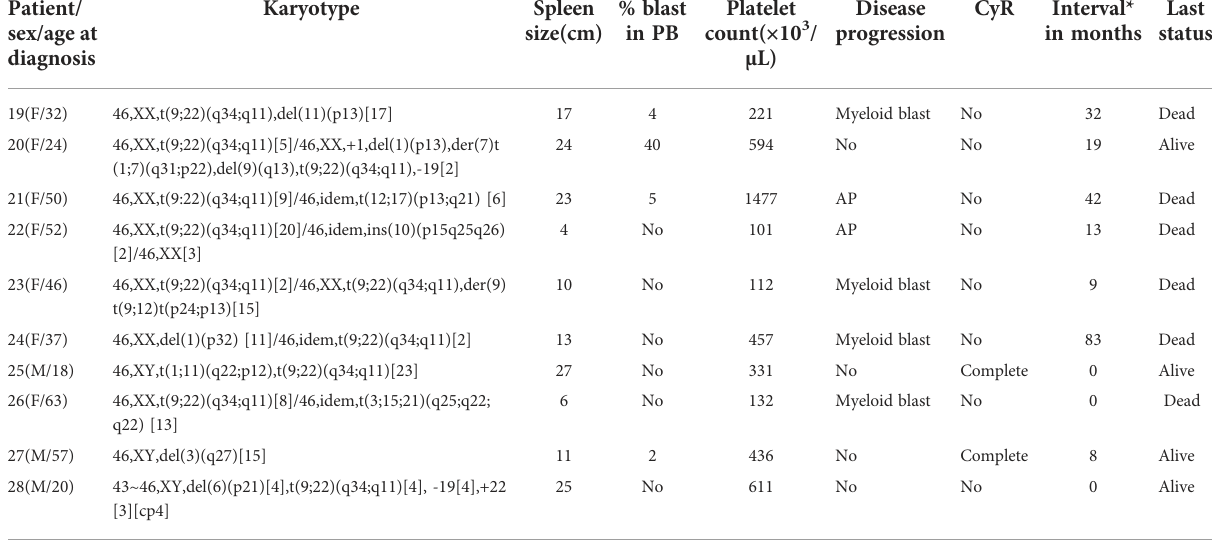
*Interval (month) between CML diagnosis and emergence of ACAs. PB, peripheral blood; CyR, cytogenetic response; AP, accelerated phase.